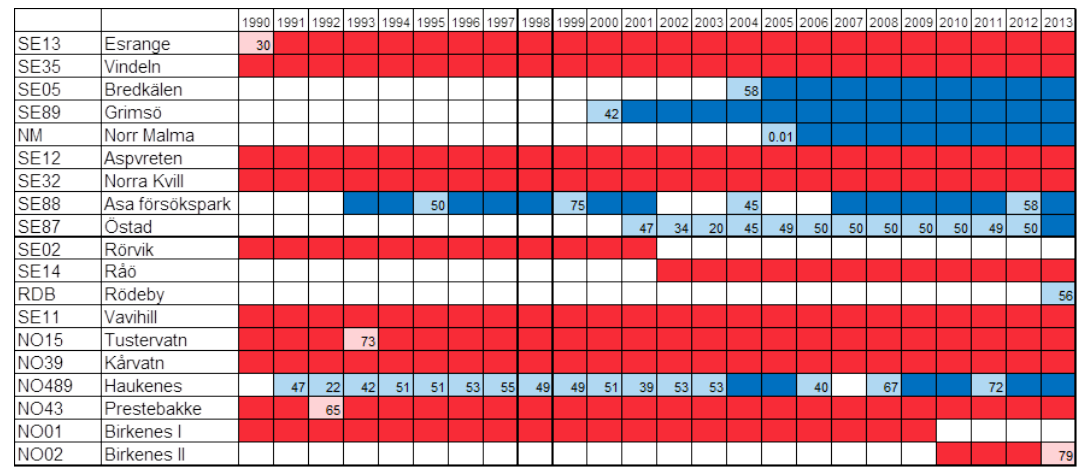
Figure 4. Data availability at instrumentation sites for hourly near-surface ozone concentration observations in Sweden and Norway. Red squares: years with at least 80% annual data for sites with full data coverage (see also Fig. 3). Light red: sites with <80% annual data (data capture indicated in square) for sites with full coverage. Blue and light blue squares: as for the red squares, but for sites with restricted data coverage. White squares: no observations are available for that year and site. The LONGTERM reanalysis includes the red measurement sites; the ALL reanalysis includes both red and